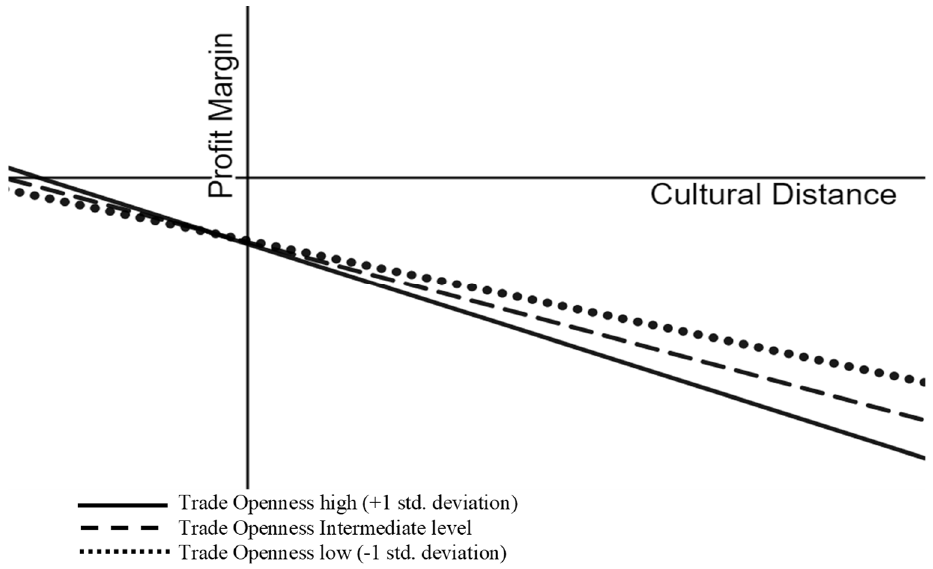
Figure 3. The moderating effects of trade openness on the CD-performance relationship.